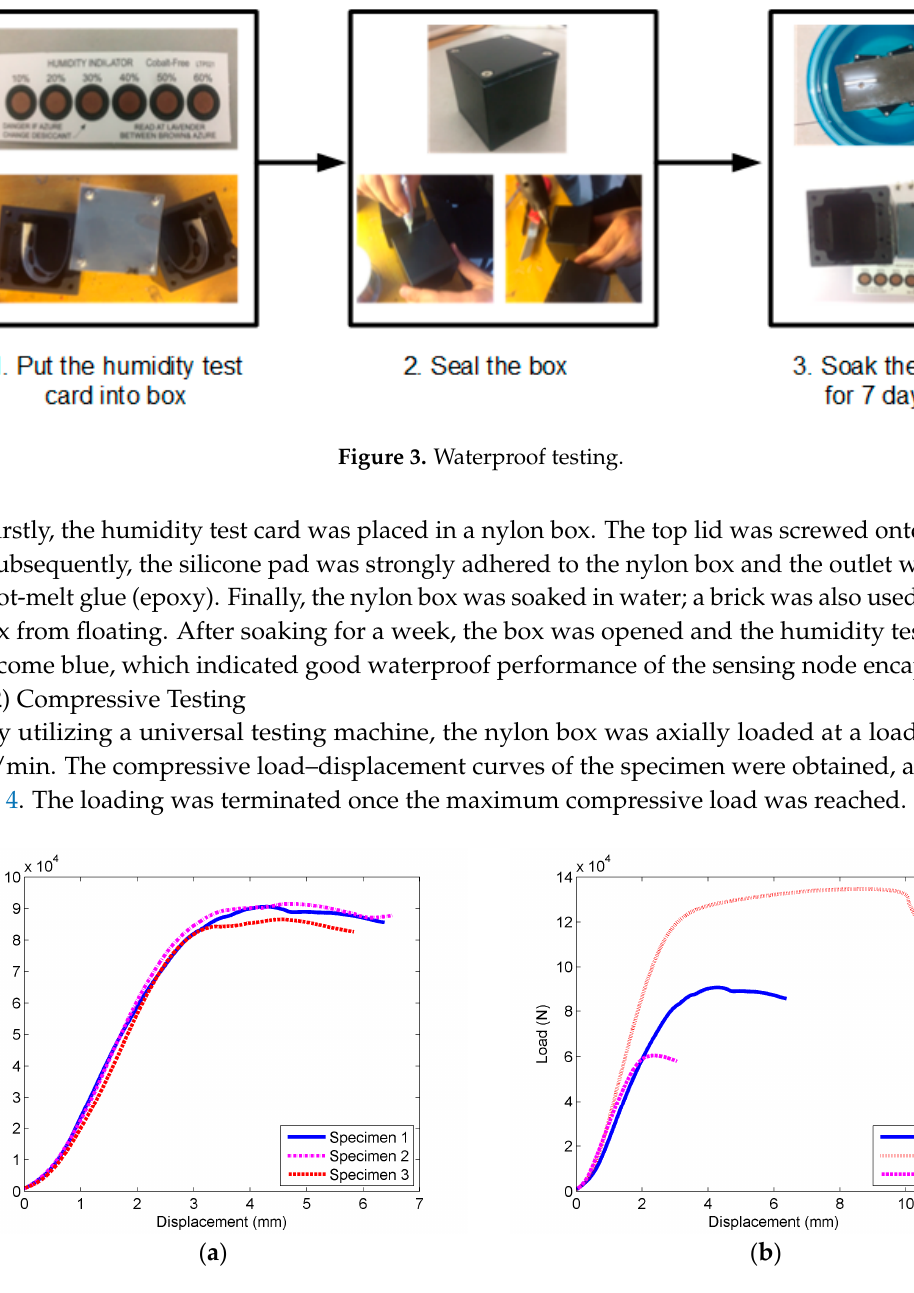
Figure 4. Load–displacement curves of the nylon box. ( a ) Compression of the front of the boxes; ( b ) Compression of different surfaces of the boxes.